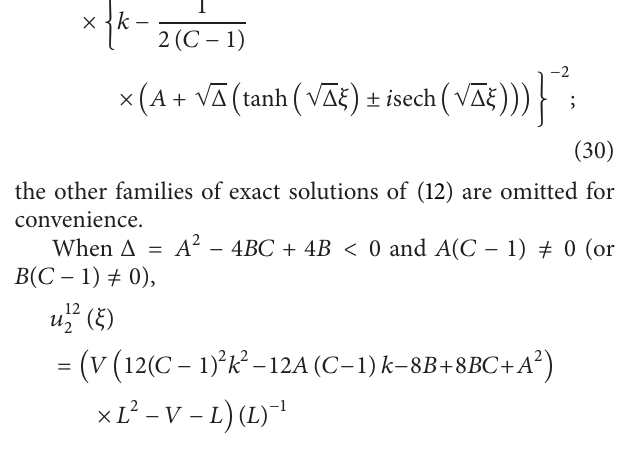
(𝜉) 𝑢 3 2 = (𝑉 (12(𝐶−1) 2 𝑘 2 −12𝐴 (𝐶−1) 𝑘−8𝐵 + 8𝐵𝐶 + 𝐴 2